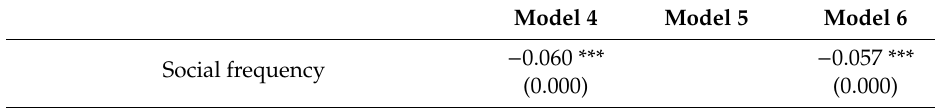
Table 6. Impact of social interaction on common pro-environmental